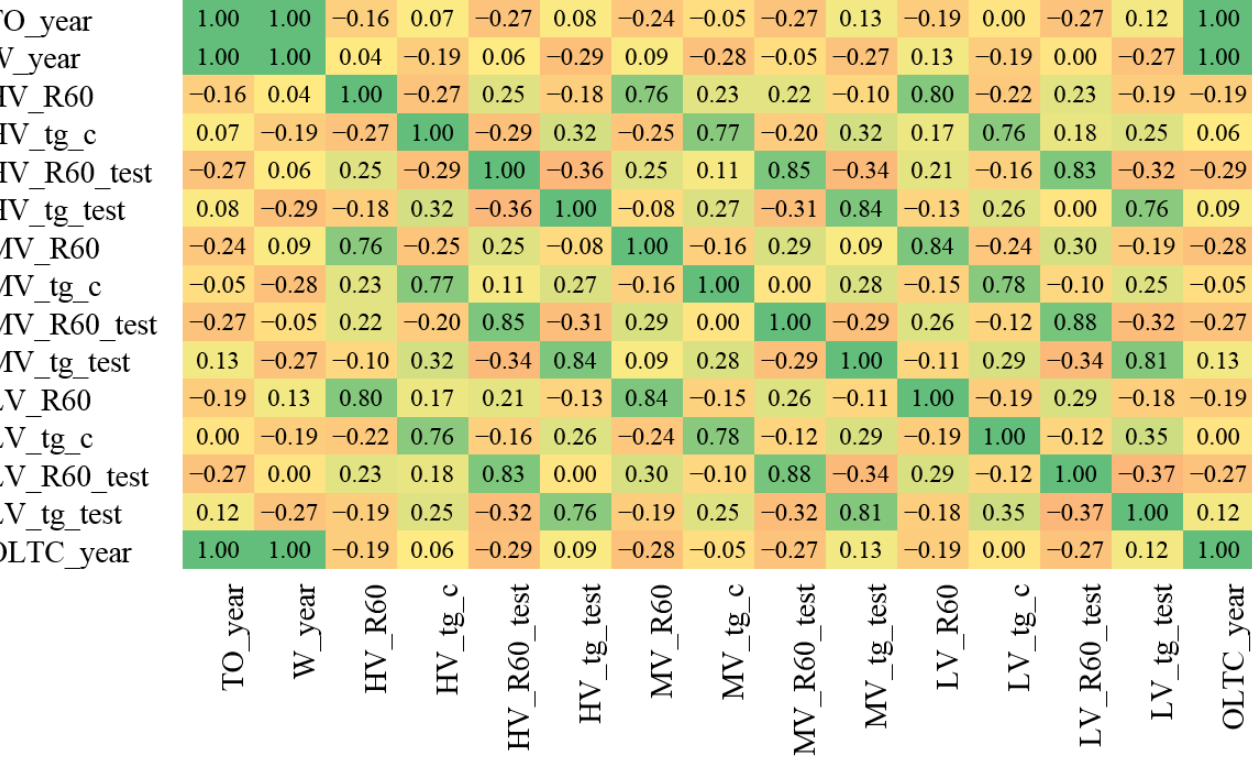
Figure 9. Spearman correlation coefficients in relation to the power transformer state.